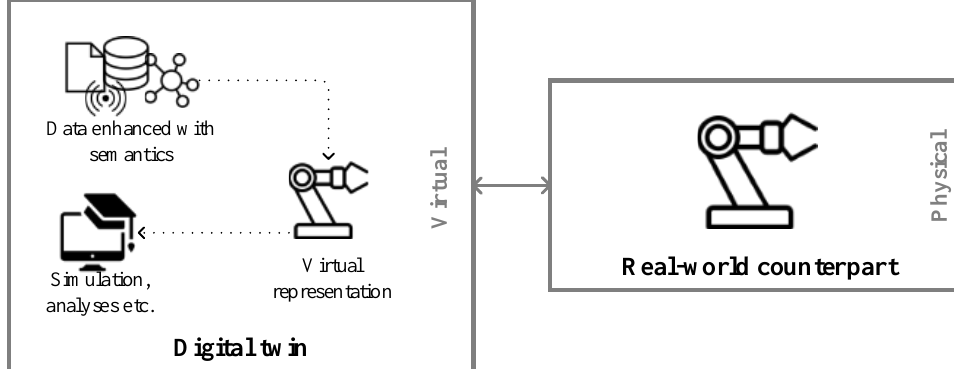
Figure 2. The conceptual structure of a Digital Twin.